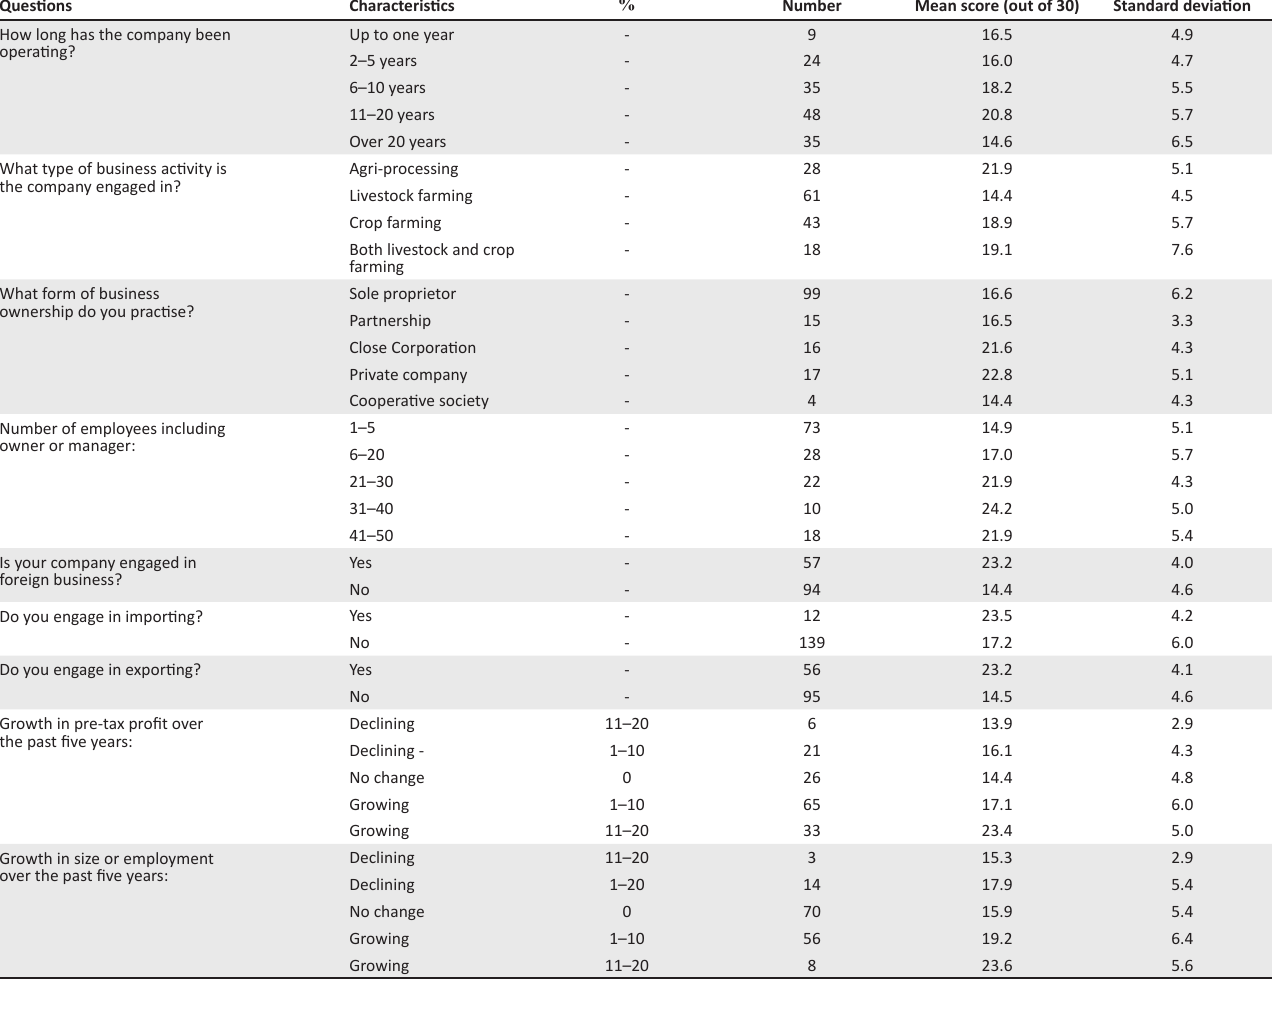
TABLE 2: Business